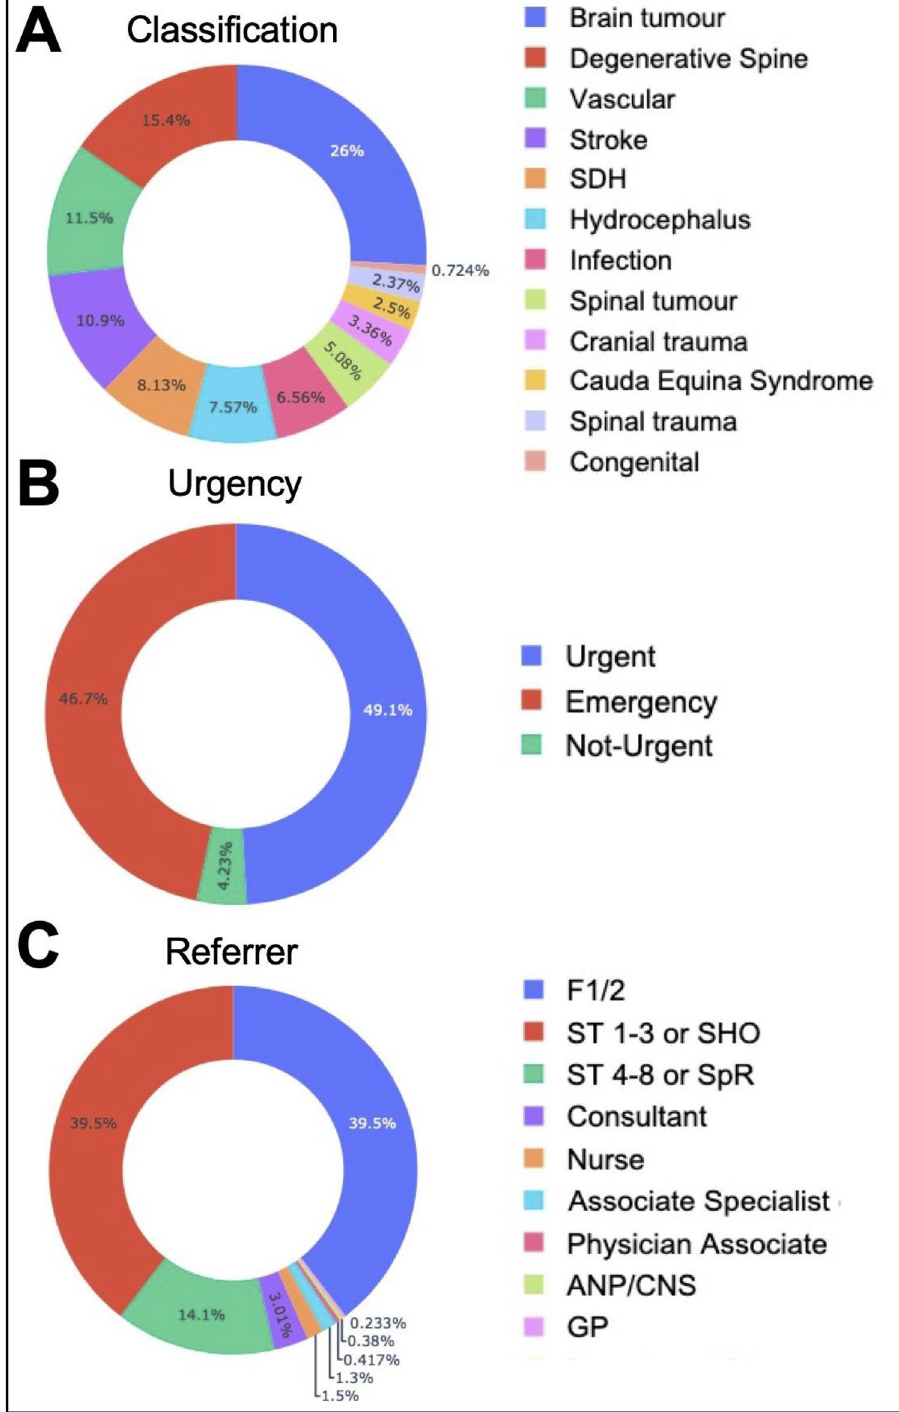
Figure 3. Referral classification. Referral proportion by diagnostic classification ( A ), urgency ( B ), referrer type and seniority ( C ) ( SDH subdural hemorrhage, F1/F2 intern/foundation year ½, SHO senior house